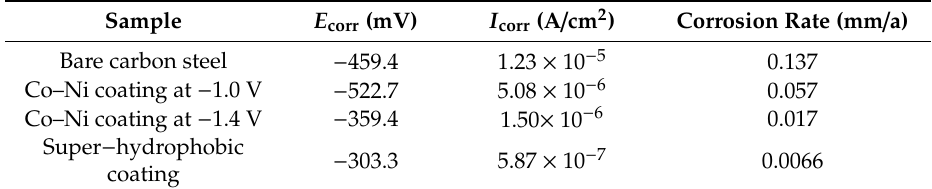
Table 3. Extracted corrosion potential ( E corr ) and current density ( I corr ) from the potentiodynamic polarization measurements presented in Figure